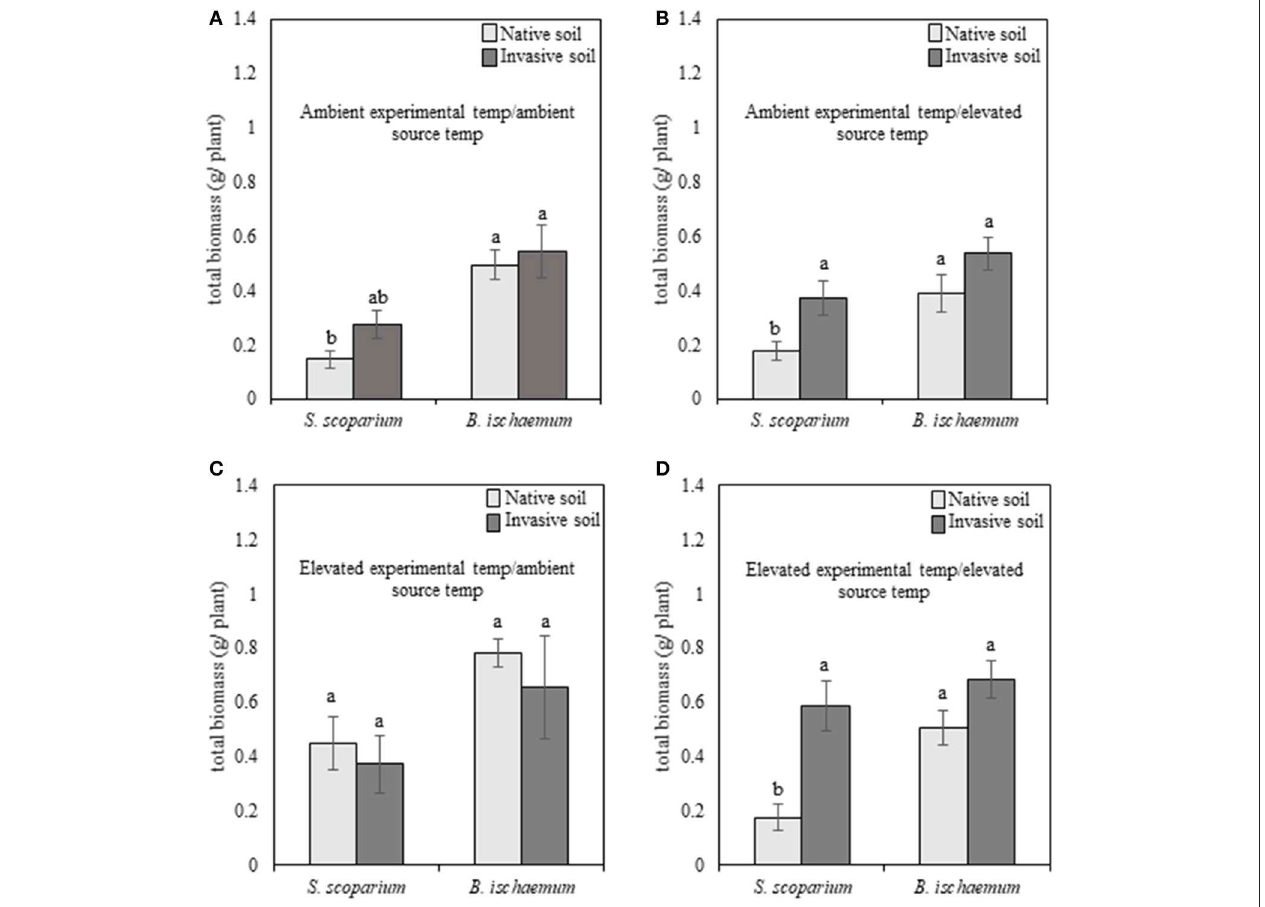
FIGURE 2 | Total biomass production of native ( Schizachyrium scoparium ) and invasive ( Bothriochloa ischaemum ) warm-season grasses grown under well-watered conditions in response to source soil plant identity and source soil temperature. Light bars indicate inoculum derived from native Schizachyrium scoparium and dark gray bars represent inoculum derived from invasive Bothriochloa ischaemum . In each panel, pairings of bars on the left represent native S. scoparium , and bars on the right represent invasive B. ischaemum . Panels represent the following treatment combinations: (A) ambient experimental temperatures, ambient source temperatures, (B) ambient experimental temperatures, elevated source temperatures, (C) elevated experimental temperatures, ambient source temperatures, and (D) elevated experimental temperatures, elevated source temperatures. Different letters indicate significant differences within panel ( p ≤ 0.05).